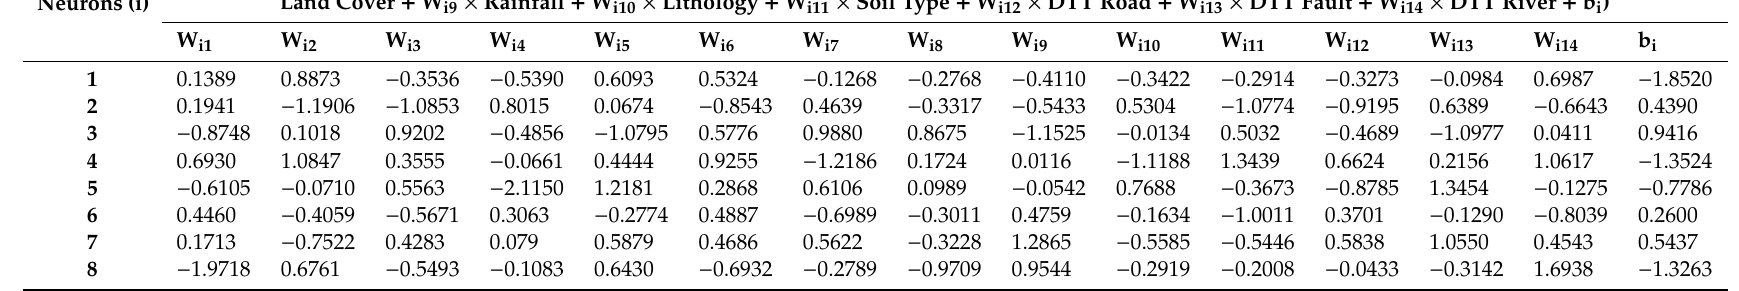
Table 5. Weights and biases of the HHO–ANN